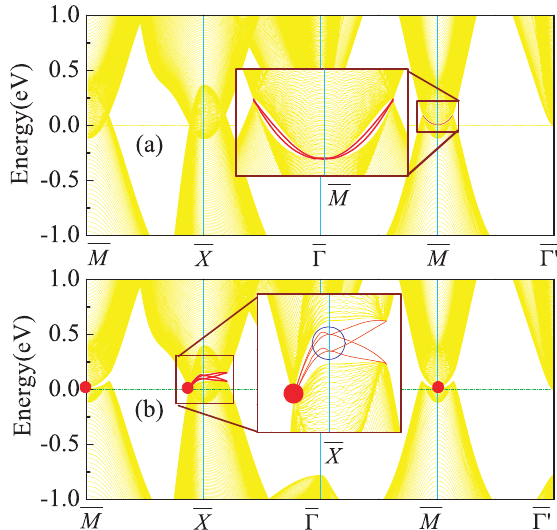
Fig. 3 The surface states of CaTe (001): a without and b with the SOC. In a , the fl at surface state around the Fermi level is denoted by red color. The inset is the detailed band structure around the M point. In b , the red dots are the projected bulk Dirac nodes. The red lines between the bulk gap at X point are the surface states and the blue circle denotes the surface Dirac cones. The inset is the detailed band structure around the X